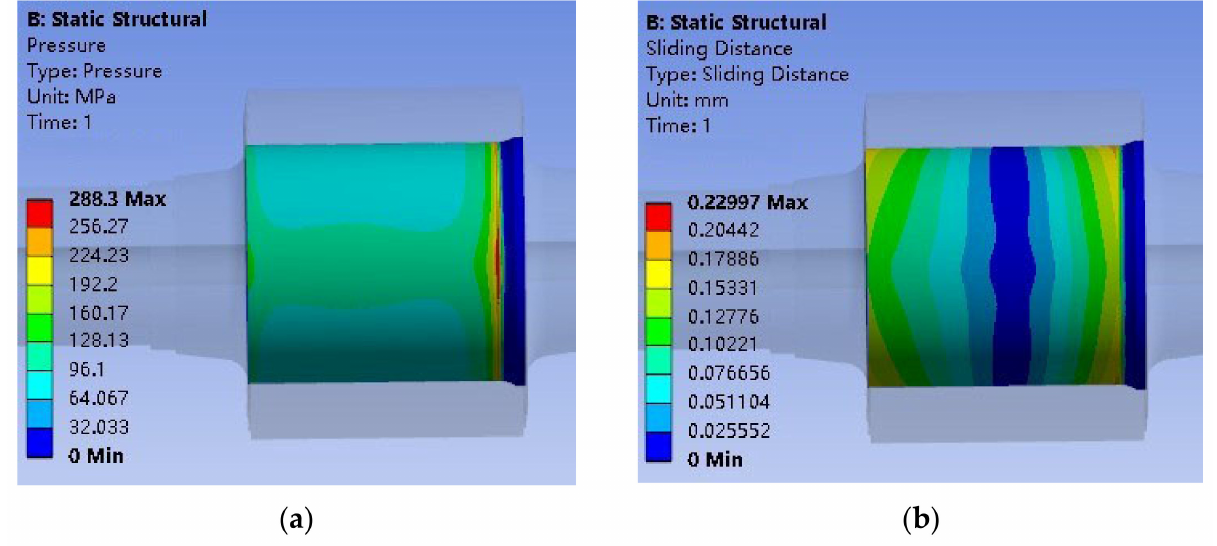
Figure 18. Interference contact nephograms after optimization: ( a ) contact stress nephogram; ( b ) sliding distance